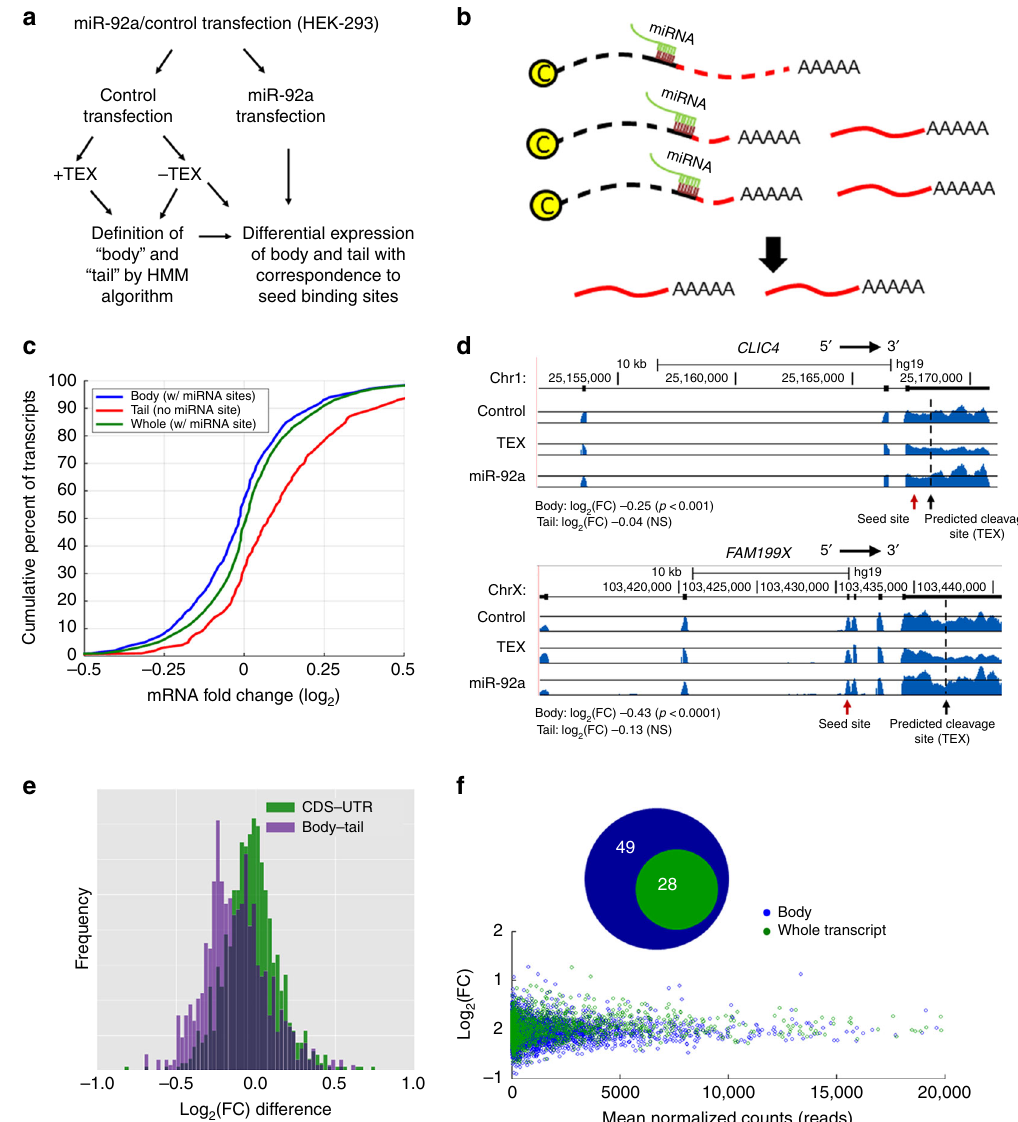
Fig. 4 Body and tail regions of cleaved transcripts are independently regulated by miRNAs. HEK-293 cells were transfected with synthetic miR-92a-3p or with a control double-stranded RNA (dsRNA), and total RNA was extracted 40 h after transfection. a Outline of experiment and data analysis. b Simpli fi ed depiction of expected results: down-regulation of transcripts with body miRNA binding sites, independent of their tails. c Cumulative frequency distributions of expression changes in transcripts with 7-mer seed binding sites in the body. X -axis corresponds to log 2 of expression fold change (log 2 (FC)). Comparison was conducted by a two-sided Kolmogorov – Smirnov test. d Normalized RNA-seq read counts from the control, TEX-treated RNA, and miR-92a-transfected cells for CLIC4 (top) and FAM199X (bottom). Predicted cleavage sites and miR-92a 7-mer seed sites in their body region are shown (arrows). e Histograms of log 2 fold change differences in body vs. tail regions (purple) in transcripts with predicted cleavage site; or between coding sequence (CDS) vs. 3 ′ -UTR (light green) in transcripts without predicted cleavage site; and the overlap between them (dark purple). In all transcripts, a miR-92a binding site was located exclusively in either body/CDS region, or in tail/3 ′ -UTR region. f Body/tail distinction identi fi es additional miRNA targets. Number of transcripts with statistically signi fi cant decrease in expression following miRNA overexpression based on the custom annotations (blue) and based on the conventional whole transcript annotation (green). Transcripts contain a 7-mer binding site in the body region. (Bottom) A scatter plot of the mean normalized counts of transcripts and their log 2 fold change by the body – tail annotation (blue plots) and by the conventional whole transcript annotation (green